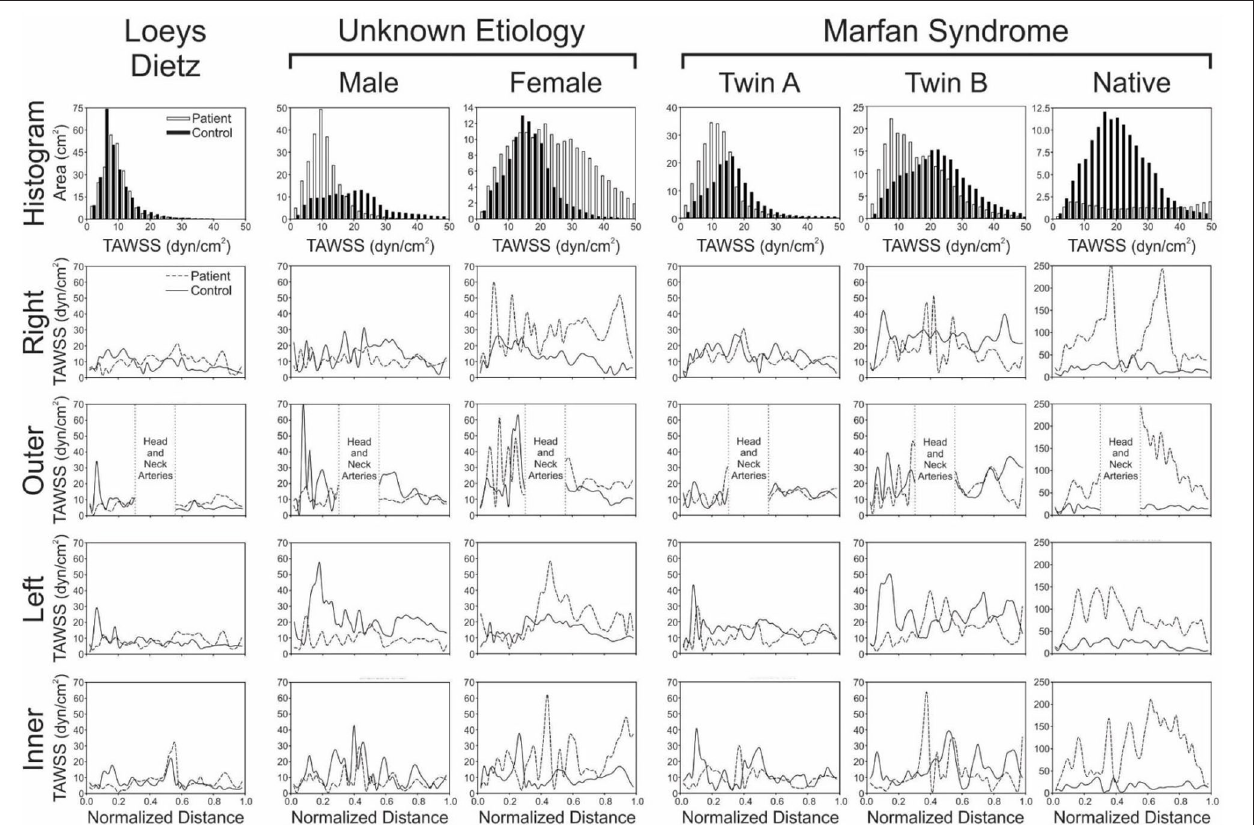
FIGURE 2 | Local quantification of TAWSS results. The top row shows histograms (2 dyn/cm 2 bins) of the area (cm 2 ) from each model surface exposed to TAWSS values from 0 to 50 dyn/cm 2 (connective tissue disease = solid bars; age- and gender-matched controls = hollow bars). Longitudinal TAWSS distributions along the outer, anatomic right, anatomic left, and inner curvatures of the aorta are also shown in subsequent rows for the patients with various connective tissue disease (dashed lines) vs. their associated age- and gender-matched controls (solid lines). Low TAWSS is generally thought to promote atherogenesis, so skewing of histogram results toward lower values could be interpreted as less ideal, as could overall lower values of TAWSS along the aortic